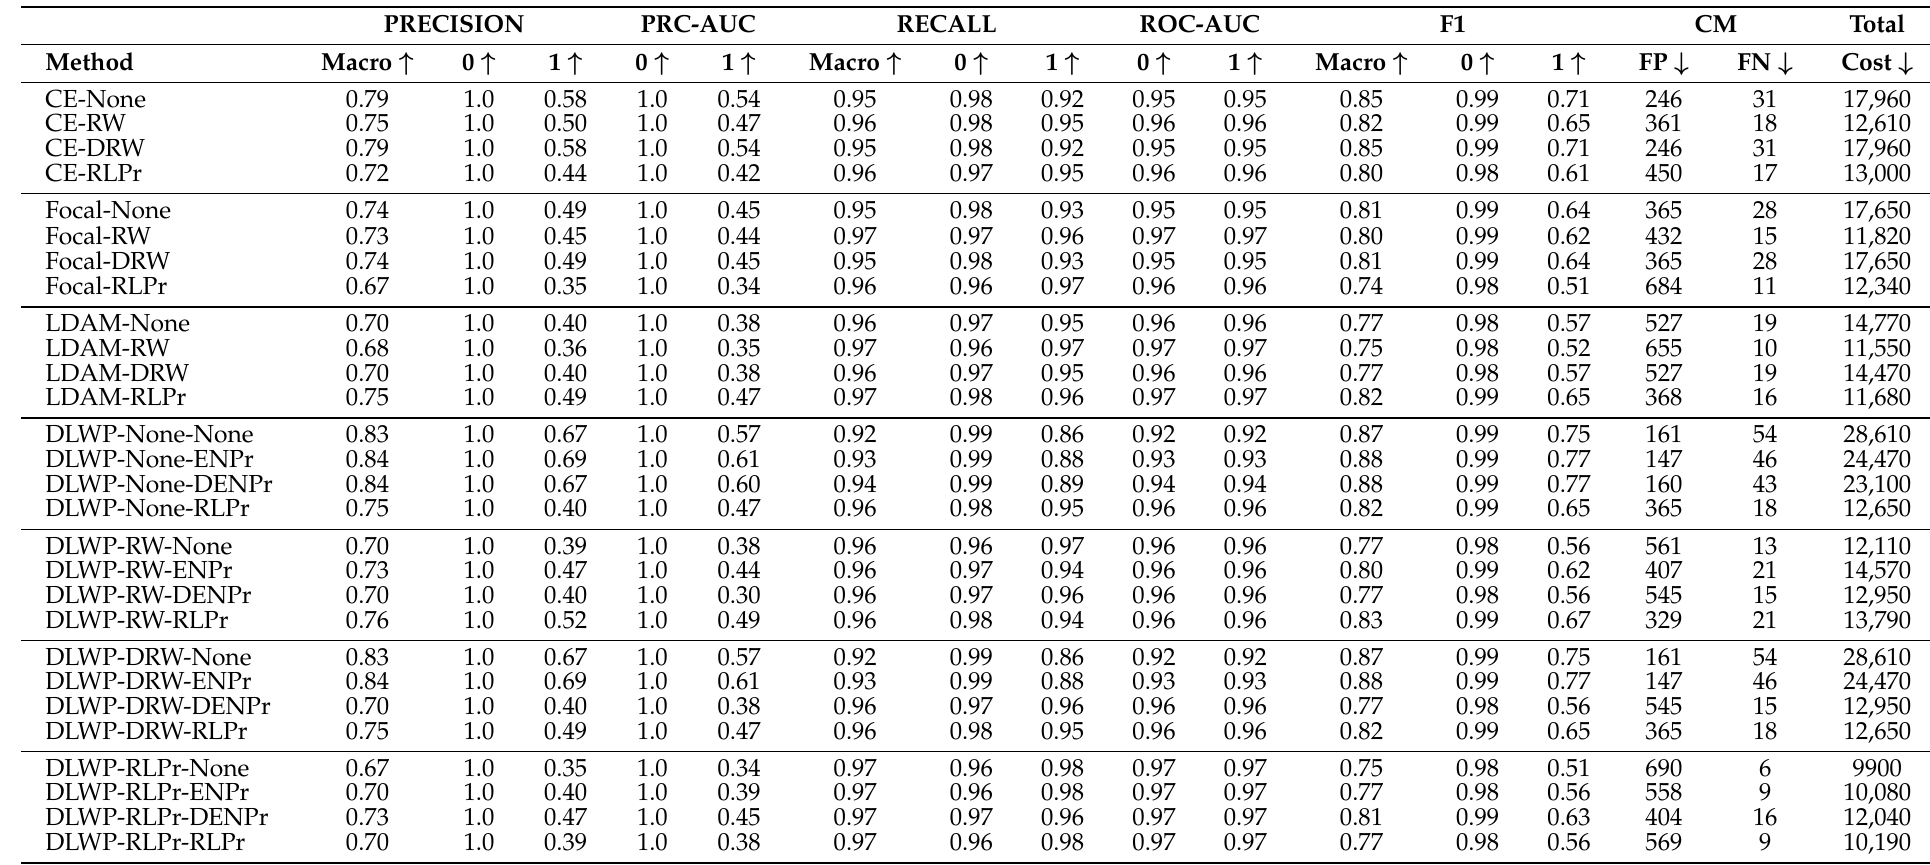
Table A1. Extended results from experiments on the APS Failure at Scania Trucks dataset. We consider the metrics Precision, PRC-AUC, Recall-Macro, ROC-AUC, F1, and CM